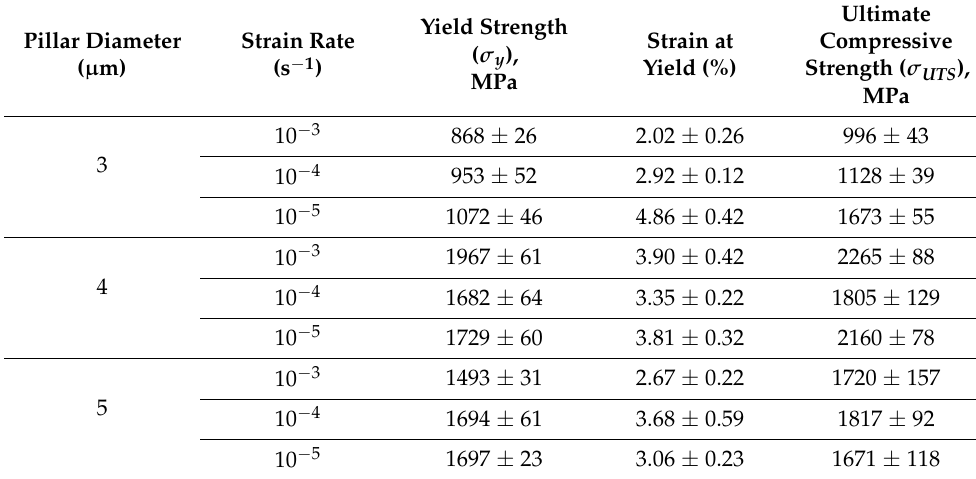
Table 1. Key mechanical properties of the presently investigated Zr-based BMGs, determined from stress–strain curves (Figures 3 and